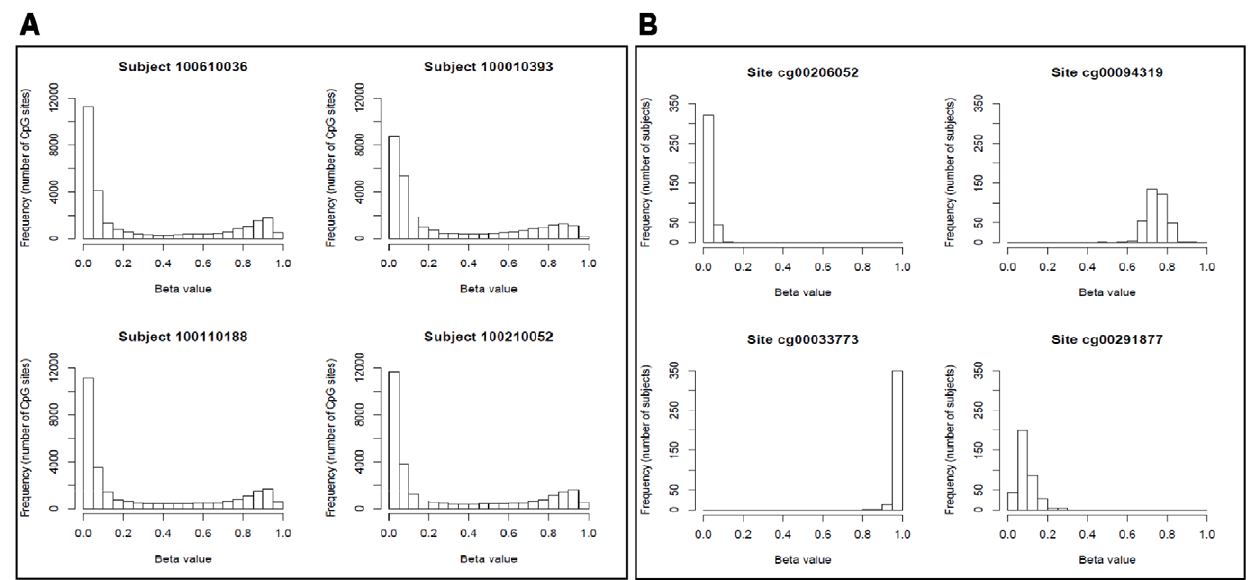
Figure 1. Distribution of b -values for selected subjects and CpG sites. A) The distribution of b values for 27,249 CpG sites is displayed for four randomly selected subjects. The distribution for the four subjects is representative of the distribution for the entire sample population. B) The distribution of b values at selected CpG sites across all 367 study subjects. The four CpG sites were selected to illustrate typical methylation patterns observed in our sample population. Each CpG site displays skewed distributions, with a small amount of variation between individuals. Three of the four panels show substantially skewed distributions, most dramatically for the sites massed nearest 0 or 1. We did not observe drastic shifts in DNA methylation patterns in our sample population at individual CpG sites.